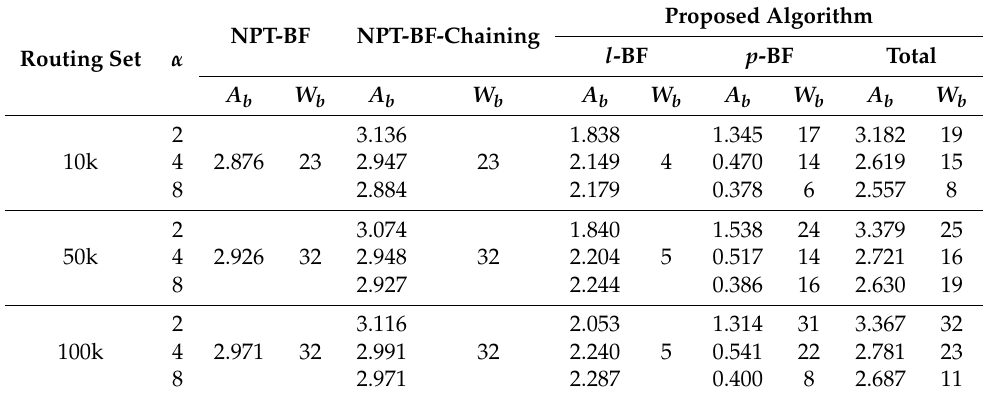
Table 5. Comparison of on-chip search performance.